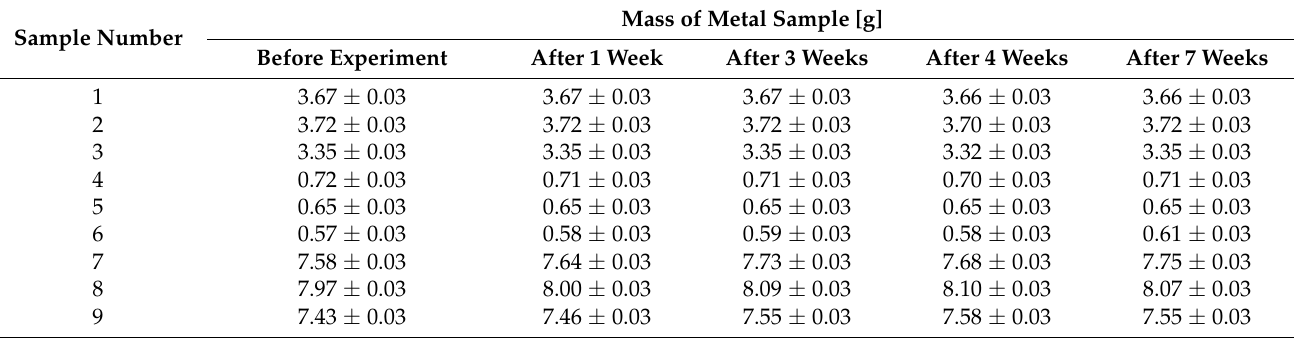
Table 3. The results of the mass measurements.